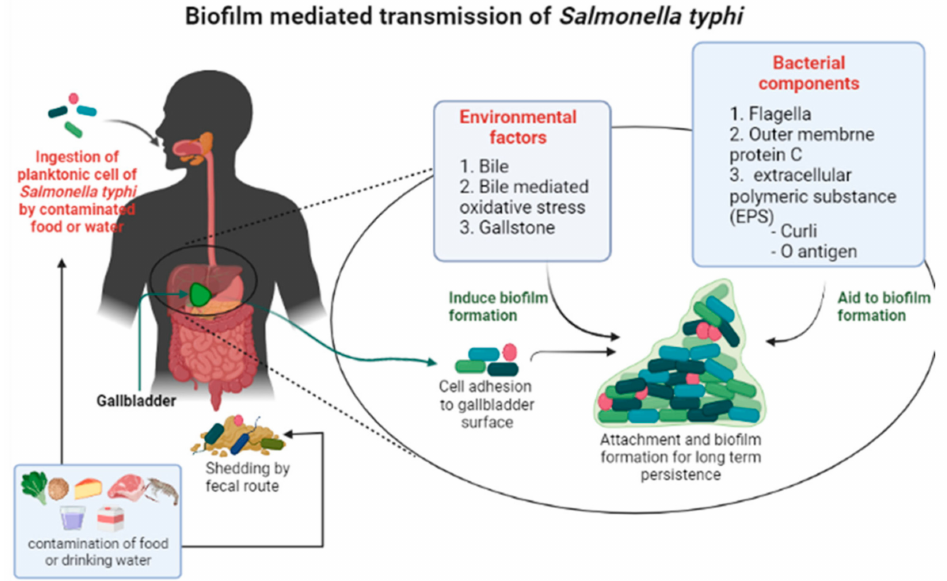
Figure 1. A schematic view of Salmonella typhi transmission process facilitated by biofilm formation in the